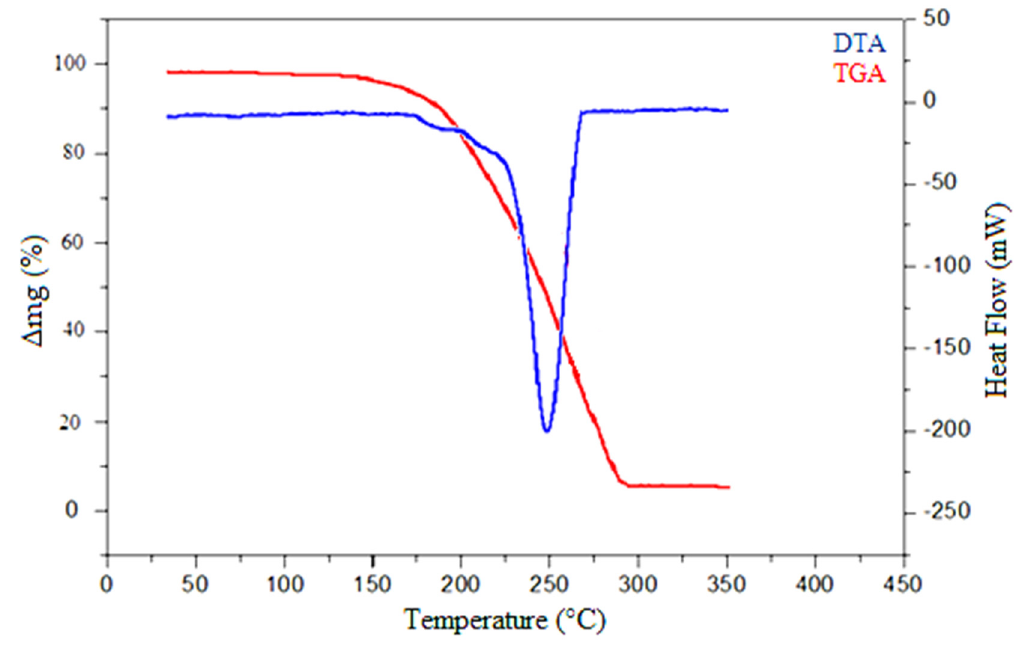
Figure 10. TGA-DTA curves for (C 9 H 14 N) 2 [CuCl 4 ].